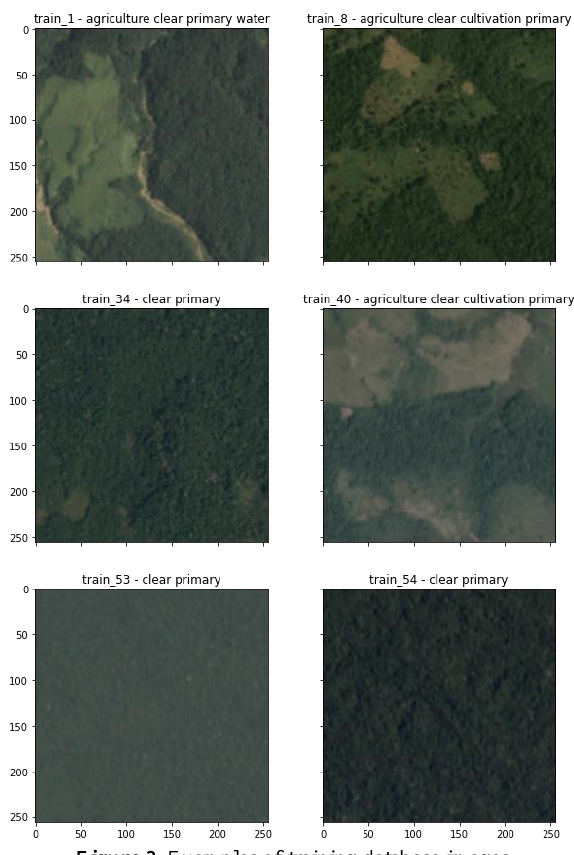
Figure 3 . Examples of training database